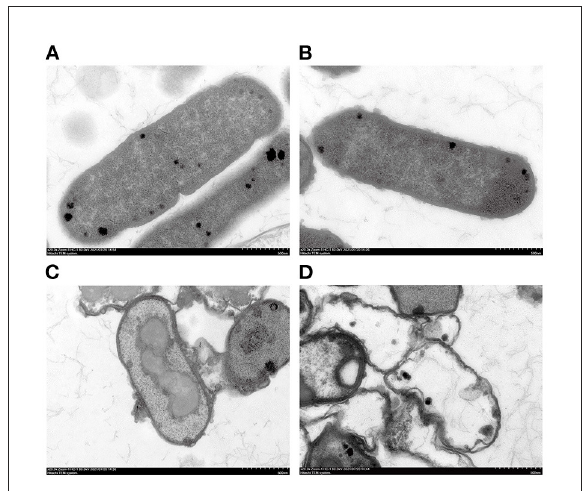
FIGURE4 TEM graphs of E. coli under different treatment conditions. (A) E. coli cultured for 12h without SSPE treatment; (B) E. coli treated with 1 mg/mL SSPE for 0.5h; (C) E. coli cultured for 6h without SSPE treatment; (D) E. coli cultured with 1 mg/mL SSPE for